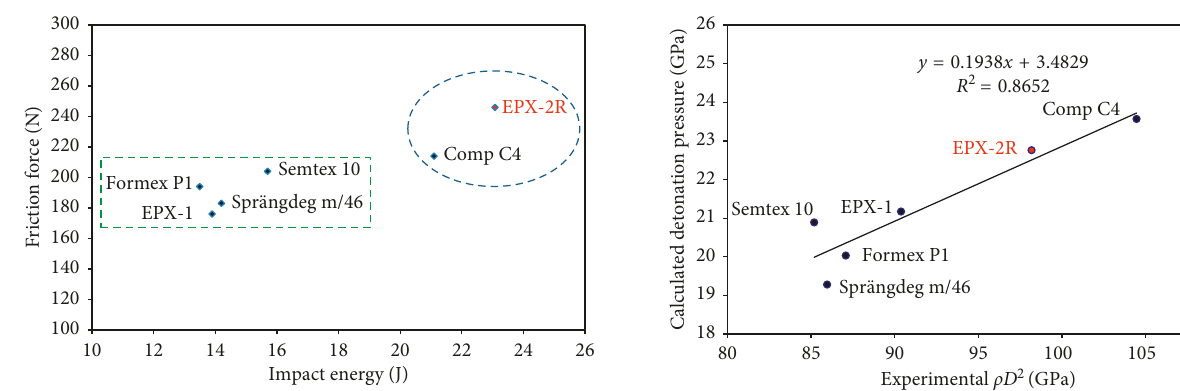
Figure 2: The impact and friction sensitivities EPX-2R in com- parison with the studied samples.